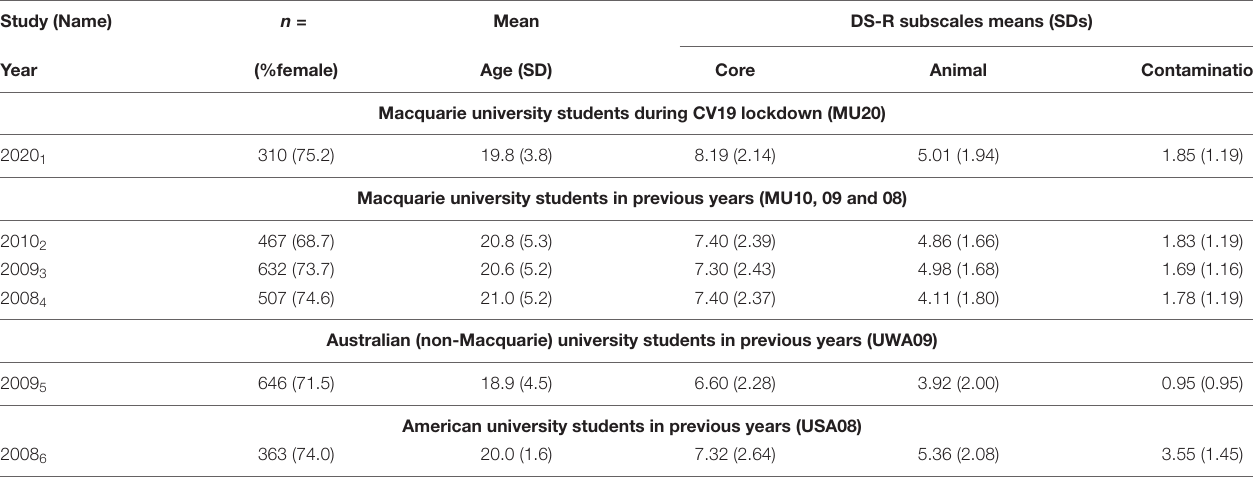
TABLE 4 | Sample details for the analyses of the Disgust Scale-Revised (DS-R).